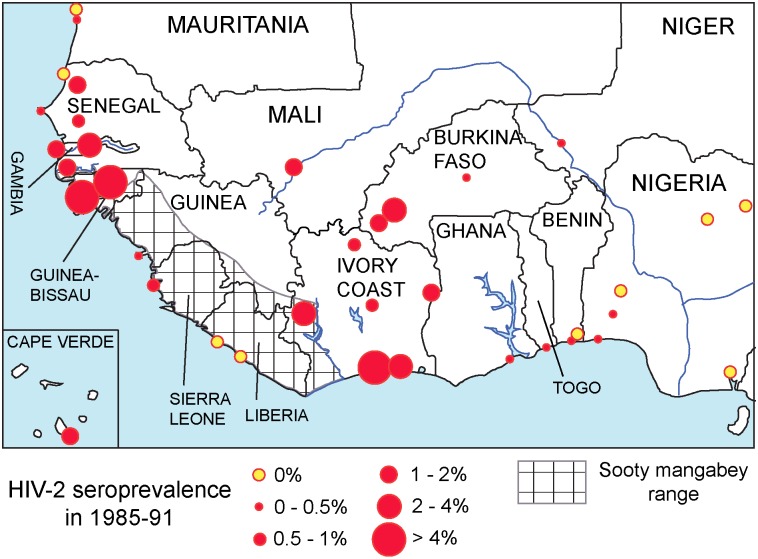
HIV-2 seroprevalence in adults without specific risk factors in West Africa, 1985–91.Complete information on HIV-2 prevalence rates is in S1 Dataset. The checkered area indicates the historical (pre-1950) range of sooty mangabeys [51–53].